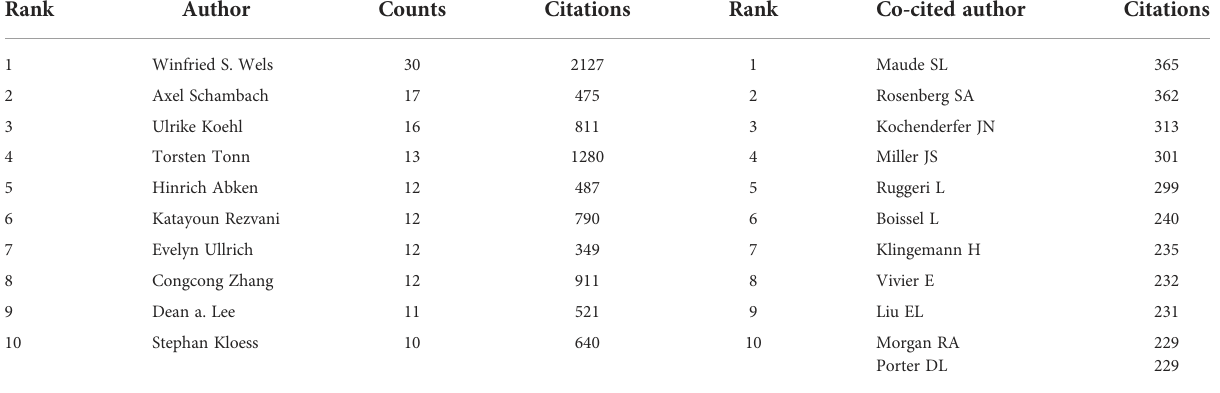
TABLE 3 The top 10 authors and co-cited authors of CAR-NK cell